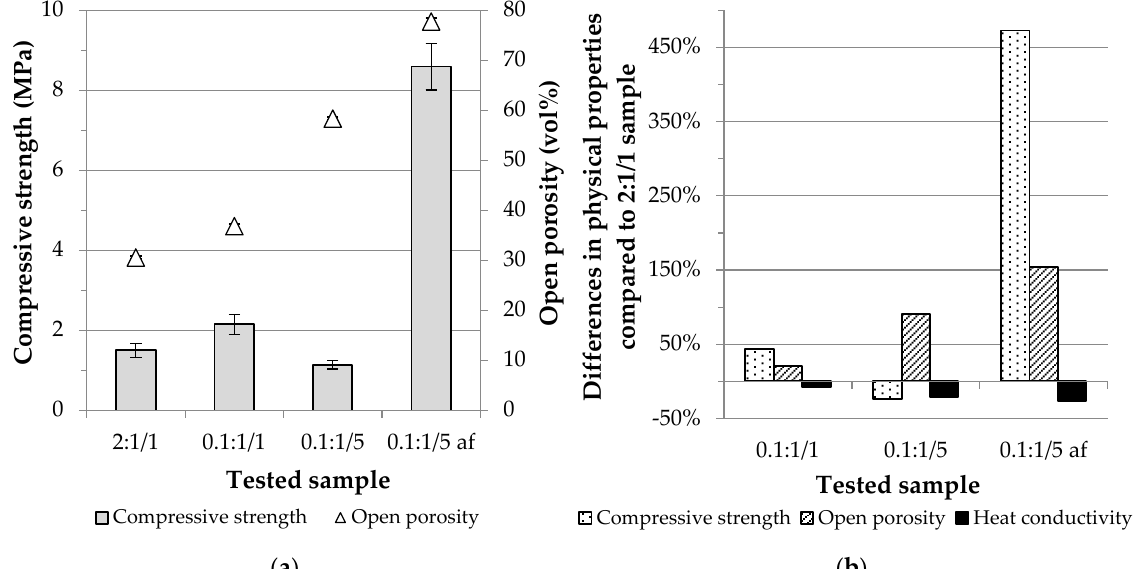
Figure 12. Comparison of the optimal results in the case of each experimental phase: ( a ) effect of experimental parameters on compressive strength and open porosity and ( b ) differences in physical properties compared to 2:1/1 sample (Samples designated as the “stabilising agent:peroxid ratio/number of heat treatment method”).